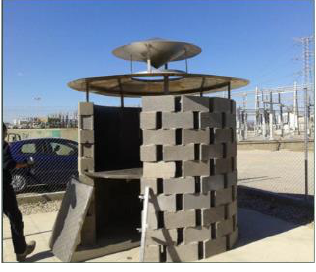
Figure 2. Self-made burner to obtain rice straw ash (RSA).